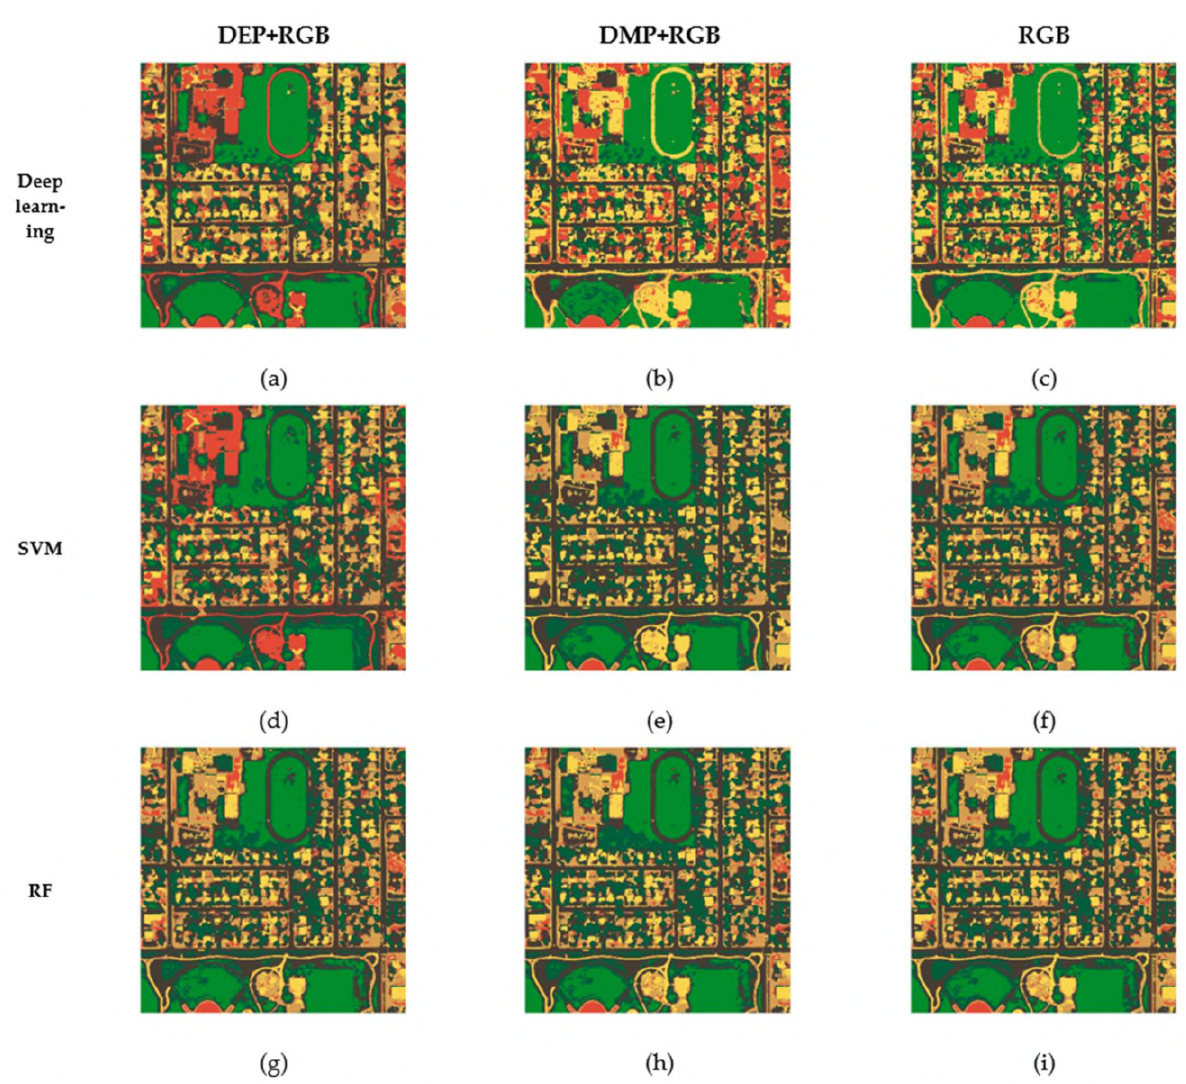
Figure 7. The classification results of ( a ) Deep learning with DEP + RGB ( b ) Deep learning with DMP + RGB ( c ) Deep learning with RGB ( d ) SVM with DEP + RGB ( e ) SVM with DMP + RGB ( f ) SVM with RGB ( g ) RF with DEP + RGB ( h ) RF with DMP + RGB ( i ) RF with RGB for Pleiades dataset. Table 6. The f-score measure for all classes in the Pleiades dataset. Trees Grass Asphalt Roof Type 1 Roof Type 2